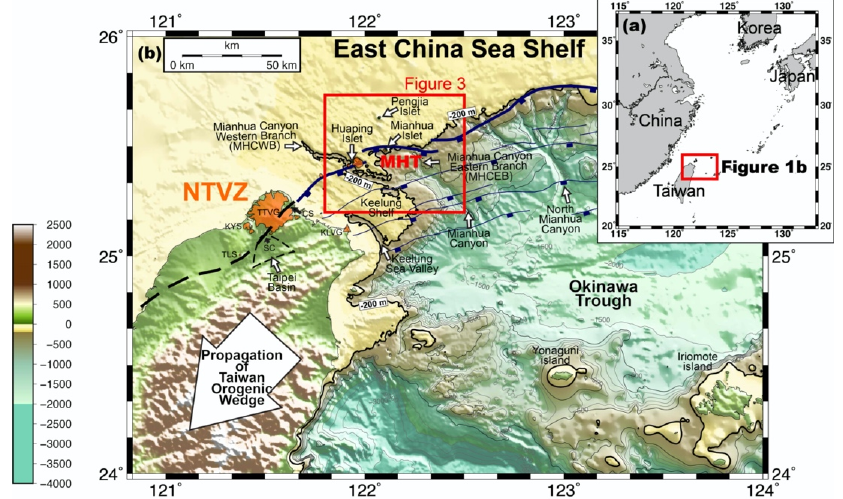
Figure 1. Maps of East Asia ( a ) and northeast offshore Taiwan ( b ). The large empty arrow indicates the propagation of the Taiwan orogenic wedge. The blue lines indicate extensional normal faults caused by mountain collapse, and the thick blue line indicates the westernmost one [12]. The black dash line indicates the position of the deformation front [11,20]. Orange areas indicate the Northern Taiwan Volcanic Zone (NTVZ) [14]. Green dots indicate the distribution of the Quaternary islets. Note that the strikes of the normal faults are parallel to the strike of the orogenic wedge, and the NTVZ is situated almost along the tectonic strike. MHT: Mianhua Terrace; TTVG: Tatun Volcanic Group; TLS: Tsaolingshan; SC: Shanchiao Fault; CS: Chinshan Fault.